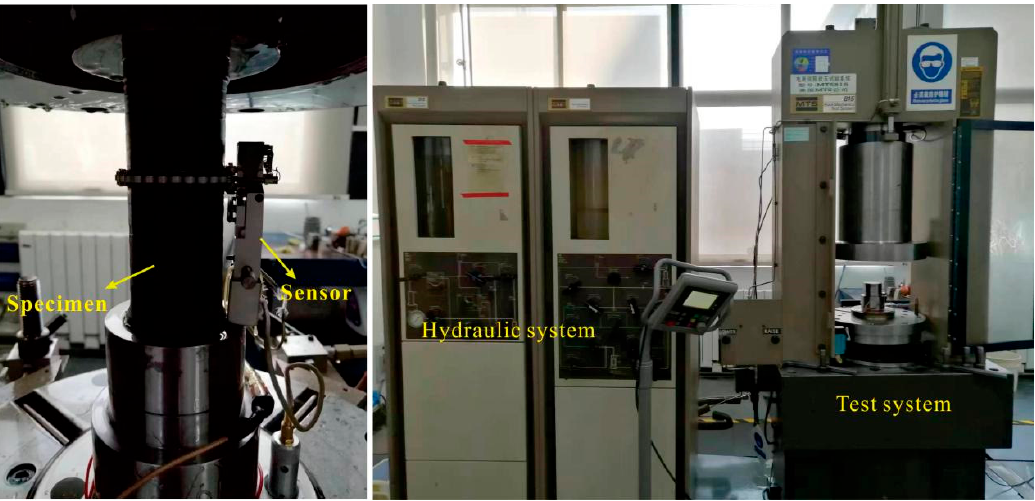
Figure 2. MTS815 test system.